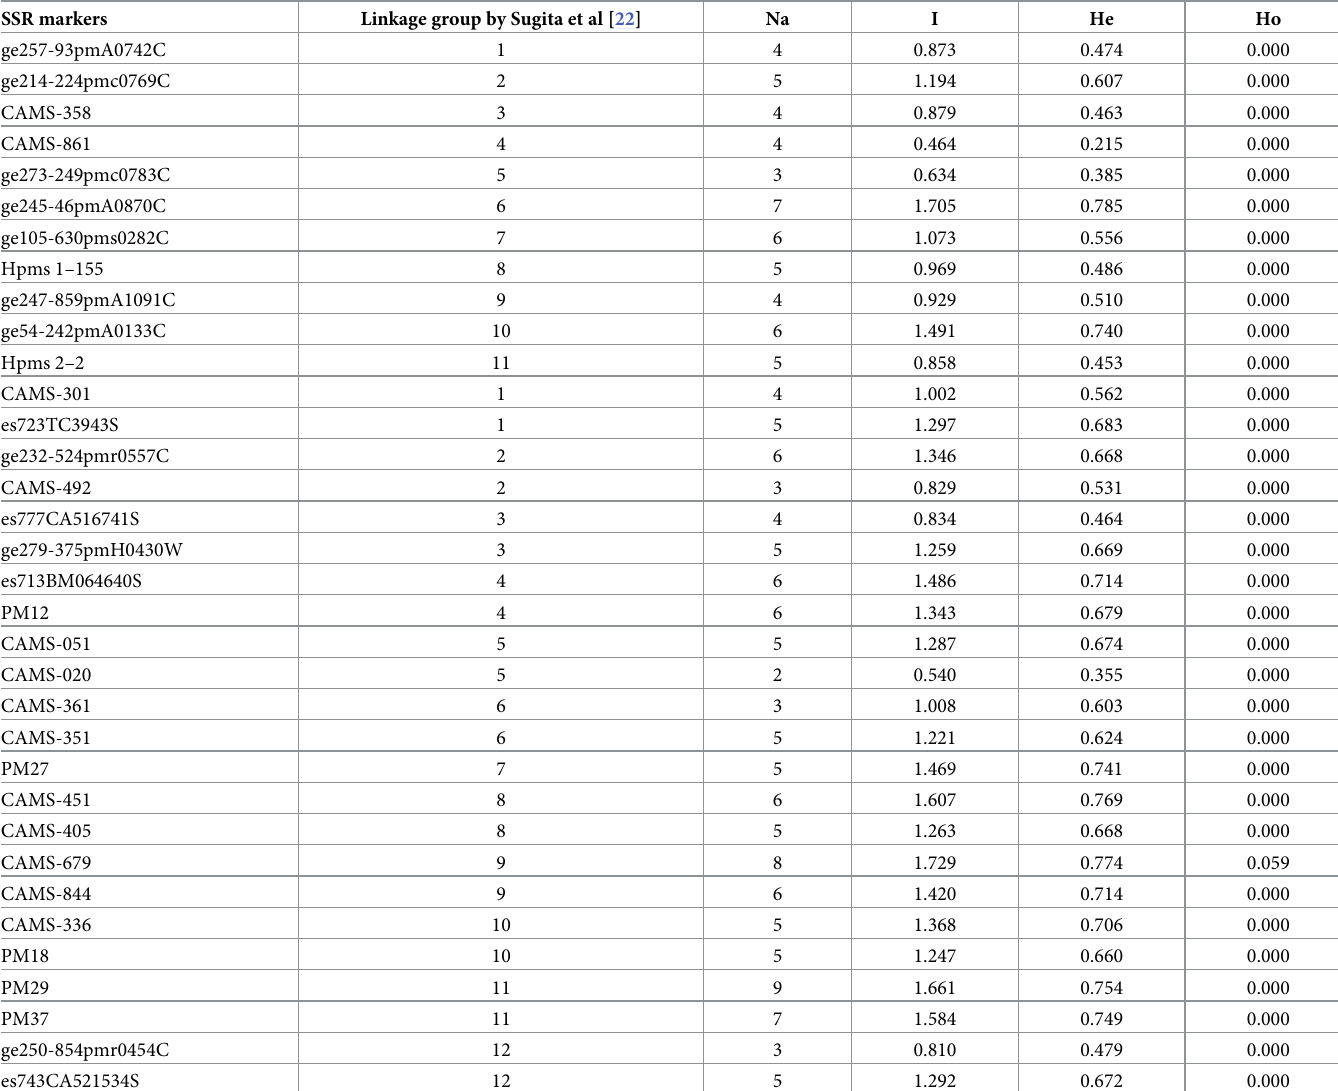
Table 2. Polymorphic information of SSR markers in the present